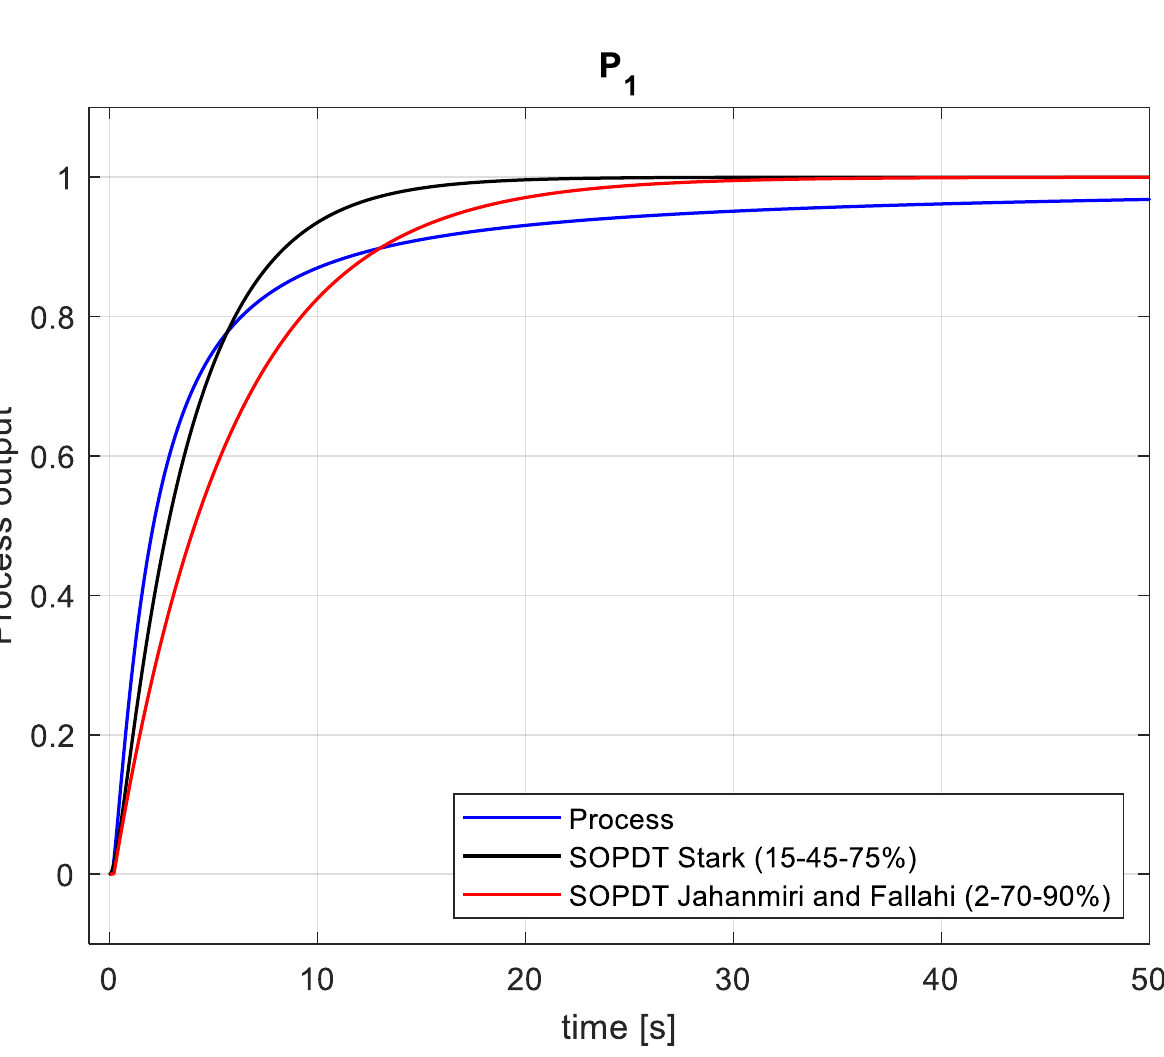
Figure 11. FOPDT and DPPDT model step responses using integer-order model identification meth- ods for process P 1 and process reaction curve: ( a ) Alfaro [11] (25 – 75%); ( b ) Vitecková et al. [14] (33 – 70%).